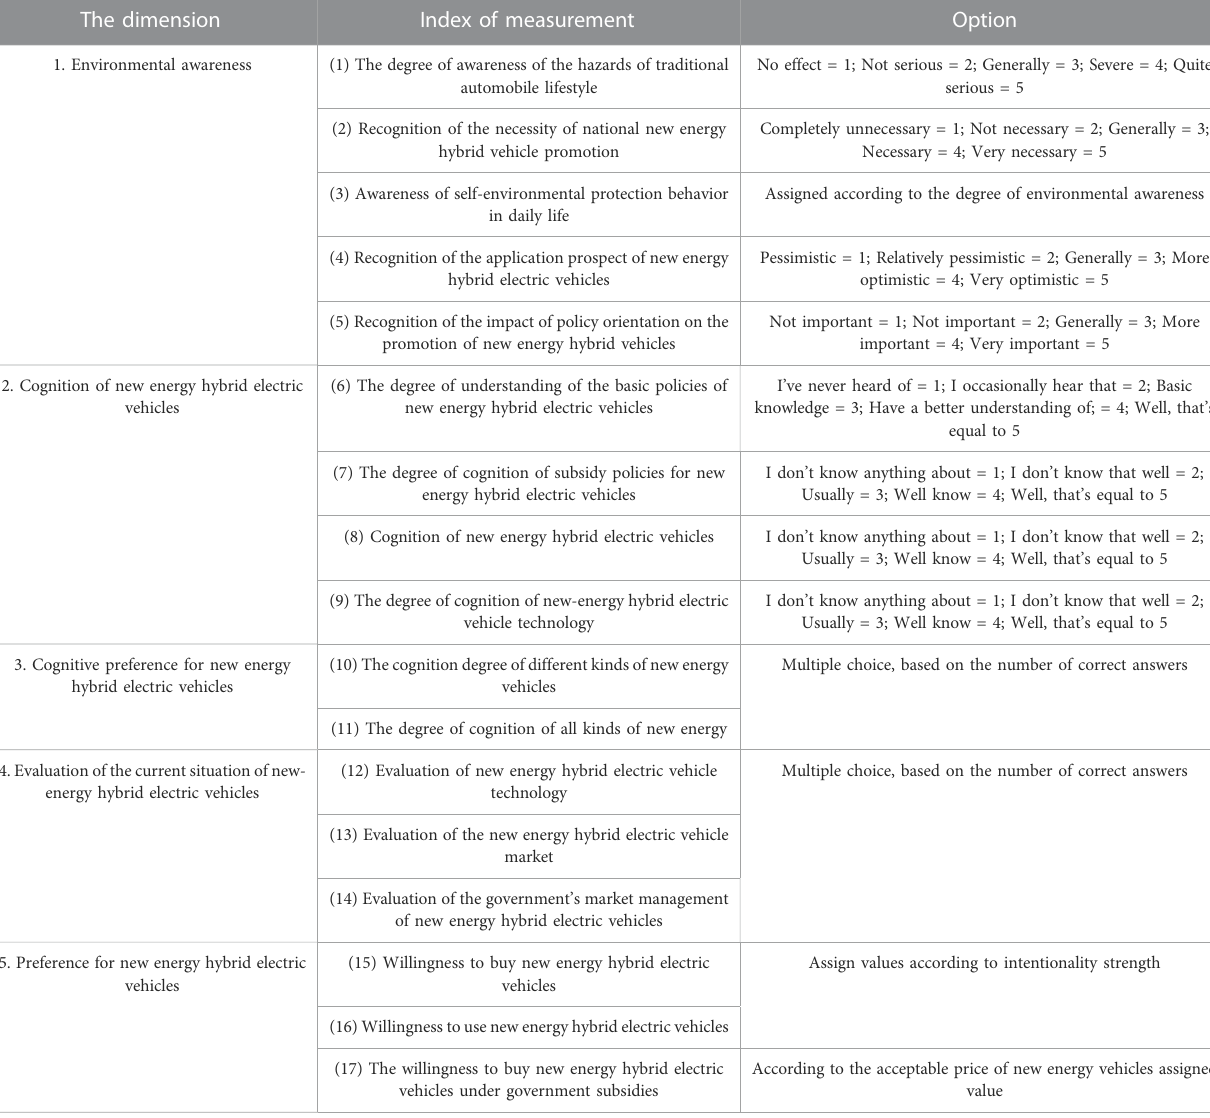
TABLE 1 17 indicators of fi ve-point Likert scale in the questionnaire. The